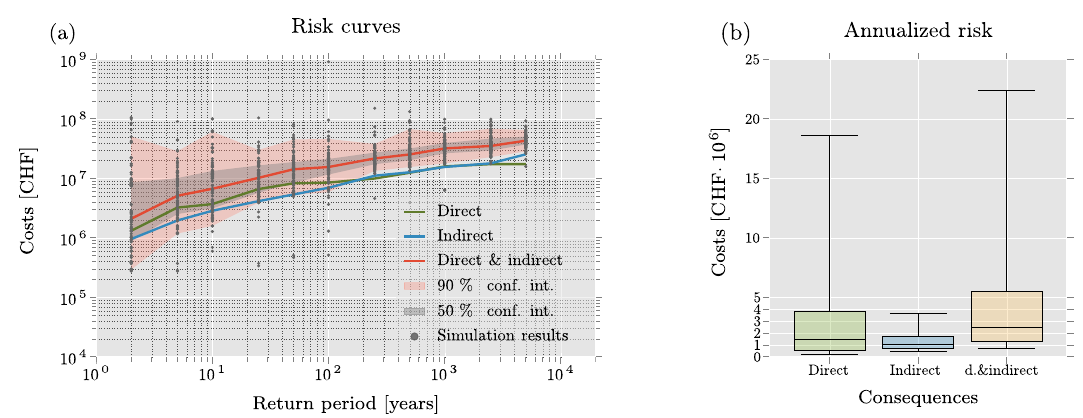
Figure 10. Risk curves and annualized risk estimations. The risk curves related to direct and indirect costs are illustrated in (a) . The 50% and 90% confidence intervals are given for the sum of the costs. Costs associated with individual simulation runs are illustrated as gray dots. Equation (4) was used to calculate the annualized risk (b) for different cost percentiles. The median annualized risk for the sum of the costs was found to be